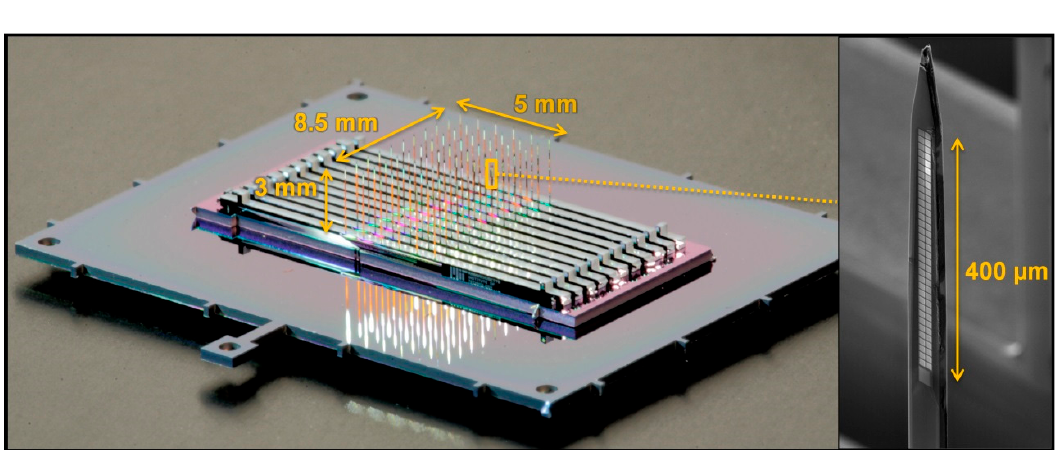
Figure 1. Photograph of a high-density 3-D probe, consisting of a 6 × 11 grid of shanks. Each shank contains a set of 2 × 34 close packed recording sites (as seen in the scanning electron microscope (SEM) inset), for a total number of 4488 sites across a volume of 5 × 8.5 × 0.4 mm.